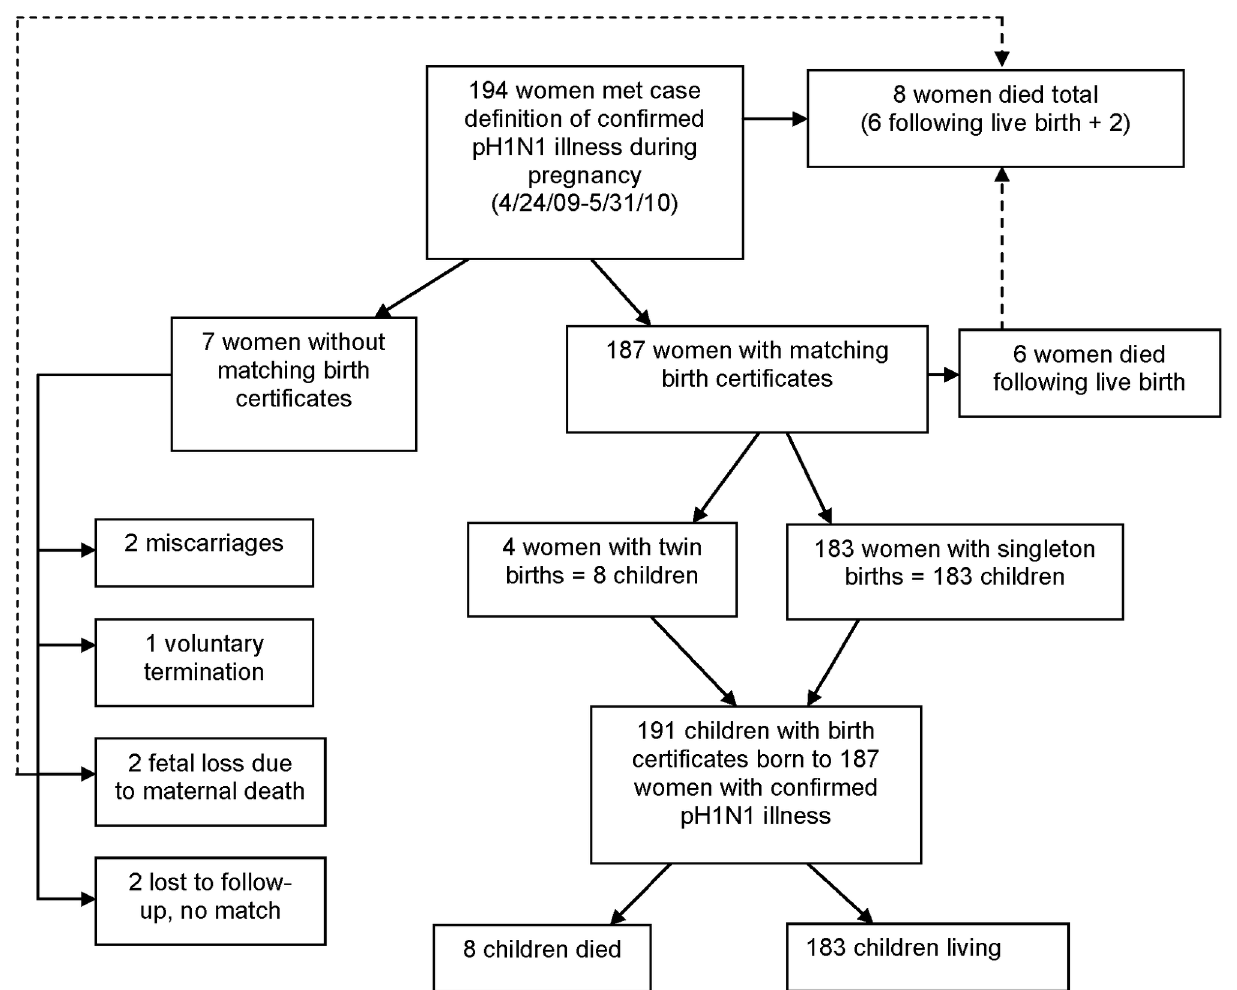
Figure 1. Distribution of case-patients by vital status and birth record